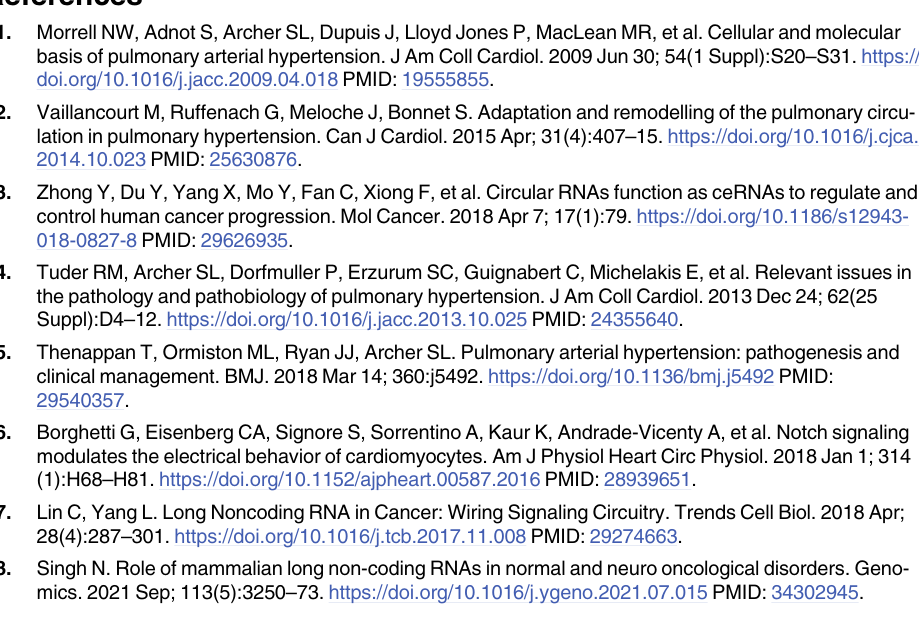
S4 Table. The up-regulated lncRNAs in the PAH groups compared to the control groups. S5 Table. The down-regulated lncRNAs in the PAH groups compared to the control groups. S6 Table. The 10 hub genes in a constructed protein-protein interaction network by MCC method. S7 Table. The lncRNA-mRNA